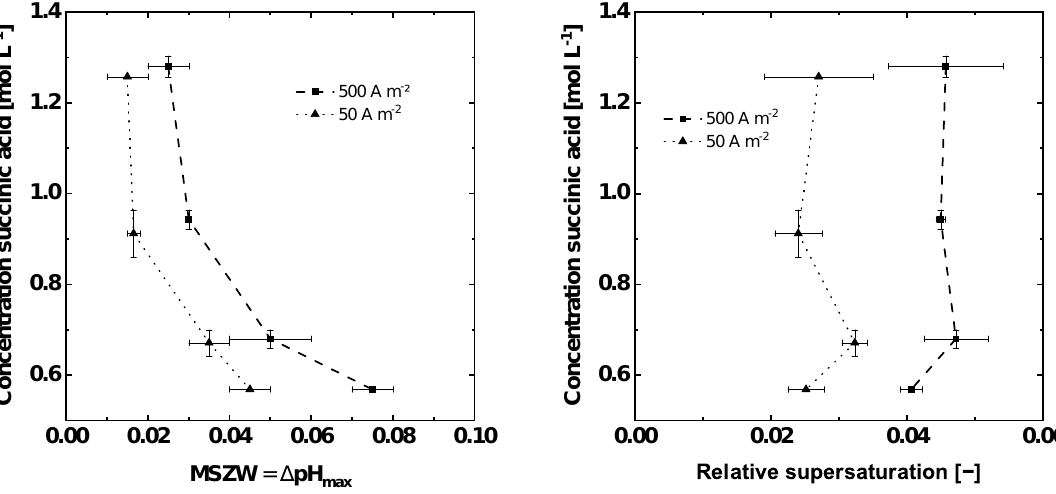
Figure 6. Effect of the applied current density and saturation concentration on the MSZW of succinic acid and on the reachable supersaturation. Dots are measured concentrations, pH values respective calculated supersaturations ( ■ ▲ ).